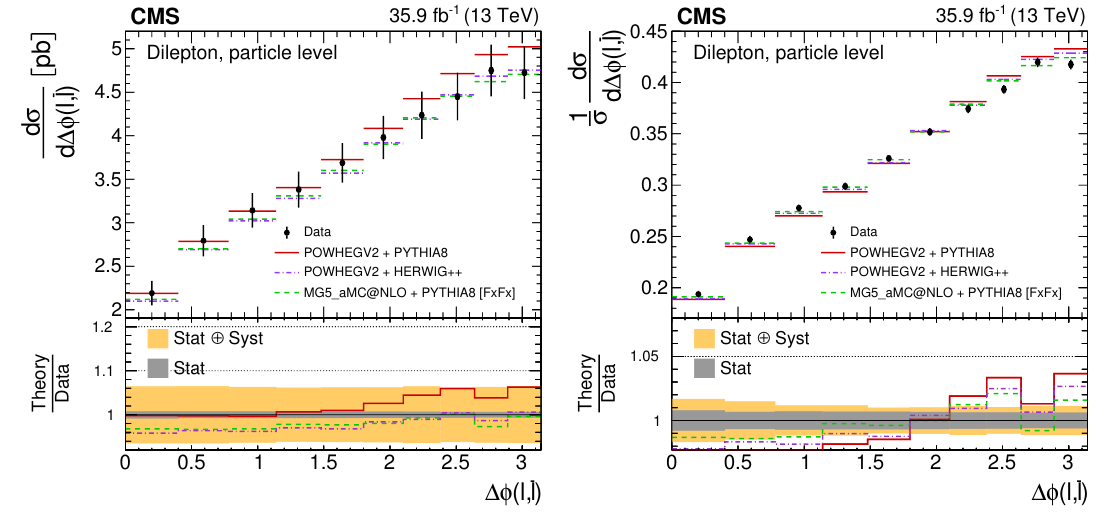
Figure 43 . The di(cid:11)erential tt production cross sections as a function of (cid:1) (cid:30) ( ‘; (cid:22) ‘ ) in a (cid:12)ducial phase space at the particle level are shown for the data (points) and the MC predictions (lines). The vertical lines on the points indicate the total uncertainty in the data. The left and right plots correspond to absolute and normalised measurements, respectively. The lower panel in each plot shows the ratios of the theoretical predictions to the data. The dark and light bands show the relative statistical and total uncertainties in the data, respectively.